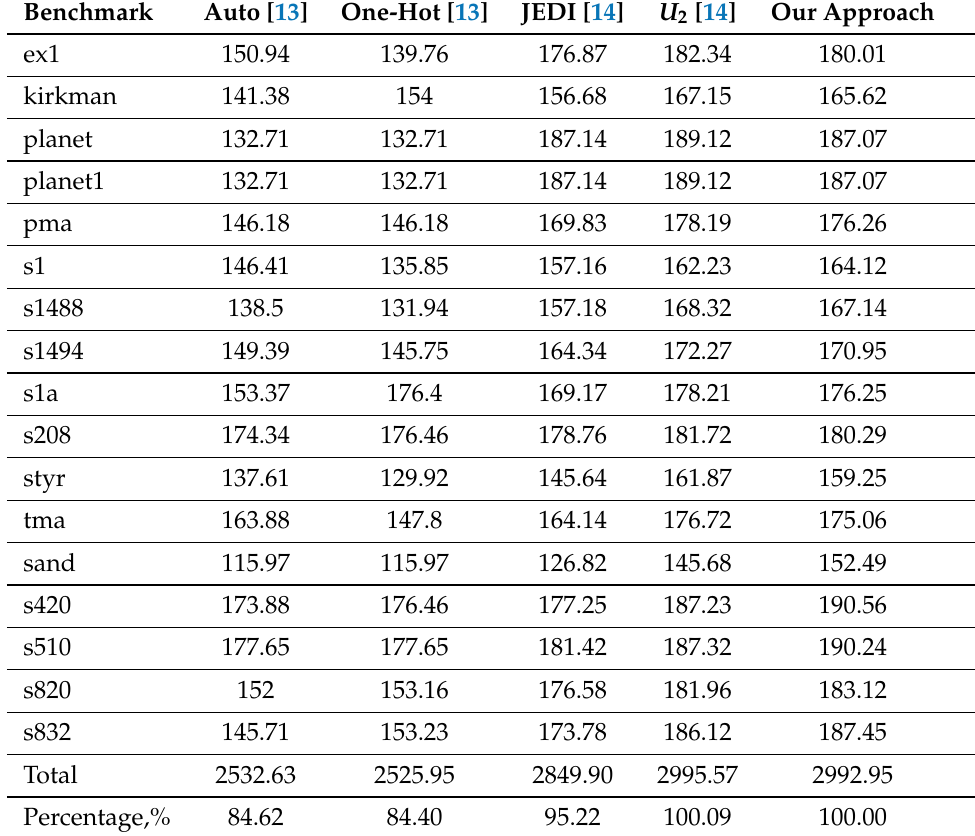
Table 15. Experimental results (the maximum operating frequency for